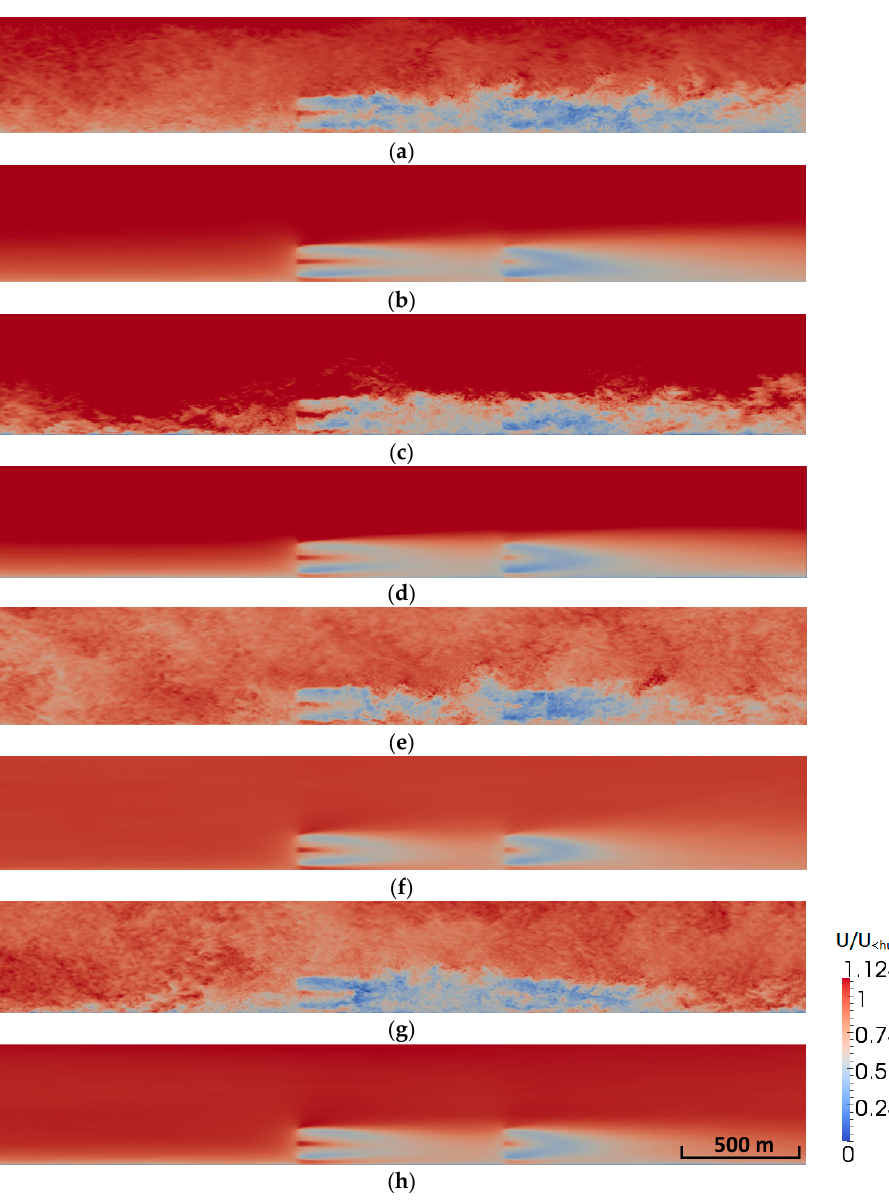
Figure 6. Streamwise view of the instantaneous and time-averaged streamwise velocities for NLABL ( a , b ), NHABL ( c , d ), ULABL ( e , f ), and UHABL ( g , h ) along the centerline. Refer to Table 1 for acronyms.